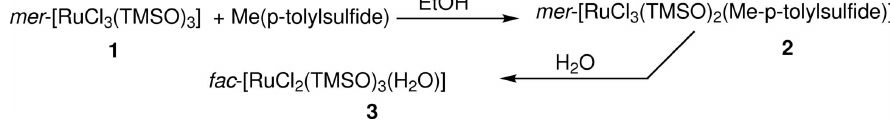
Figure 3 The formation of the title